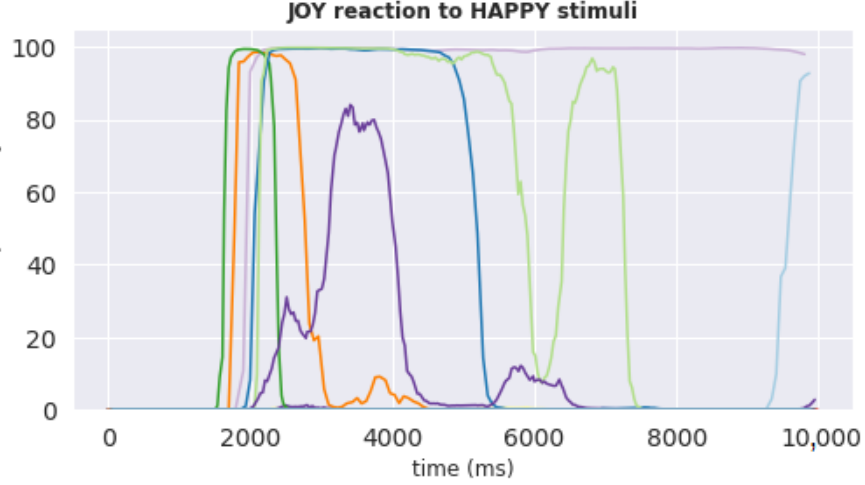
Figure 9. Joy reaction of all 50 subjects during the 10 s from the onset of being shown the happy stimulus. X-axis represents time (ms) and y-axis represents joy probability scores (%). Each uniquely colored line represents reaction of one subject, with the majority of subjects having near-zero